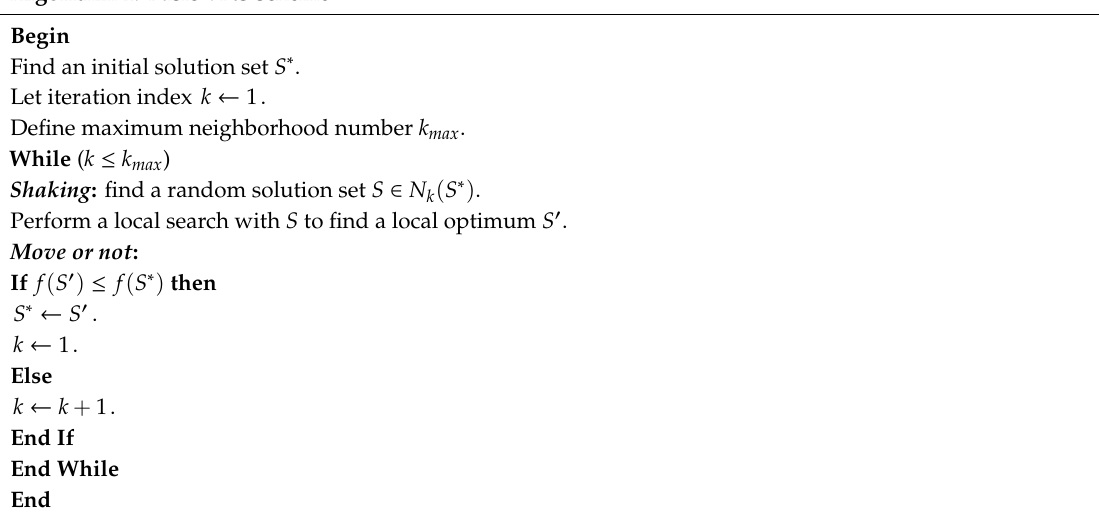
Algorithm 1. Basic VNS scheme